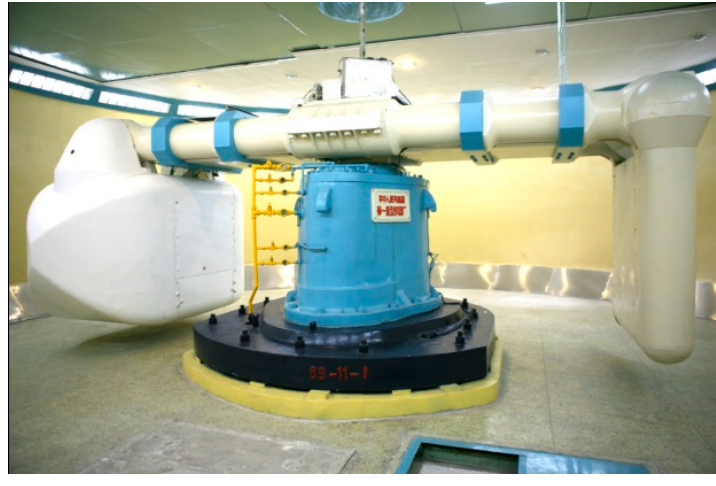
Figure 12. The centrifuge facility at IWHR.